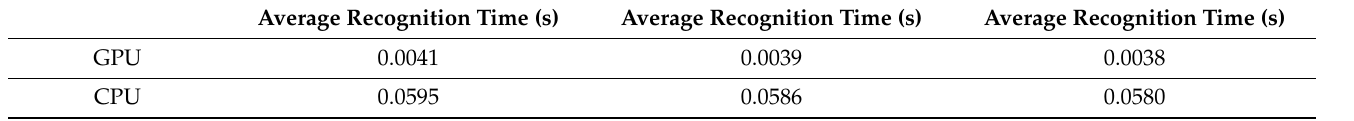
Table 6. Average recognition time for a single image on different